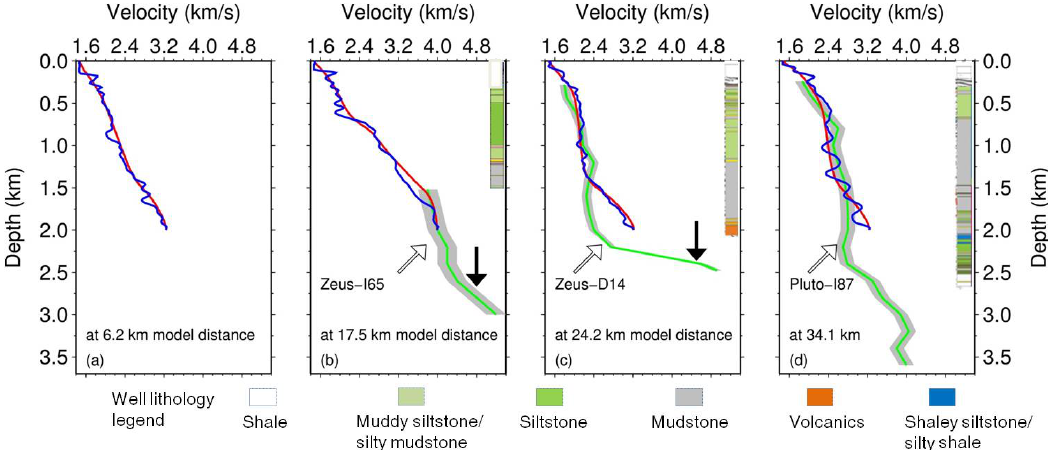
Figure 18. One-dimensional-velocity profiles through travel time inversion model (red) and full waveform inversion model (blue) along with sonic log velocties (green). Arrows in Figure 2 show locations of model velocity profiles that correspond to sonic logs. Solid black arrows indicate locations where Eocene volcanics were found in the Shell Canada exploratory wells from 1967, which have been re-evaluated by several studies, including Narayan et al. [11], Hayward and Calvert [12], and Johns et al. [5]. Lithology variations with depth from Zeus-I65, Zeus-D14 and Pluto-I87 are shown in ( b ), ( c ), and ( d ), respectively.